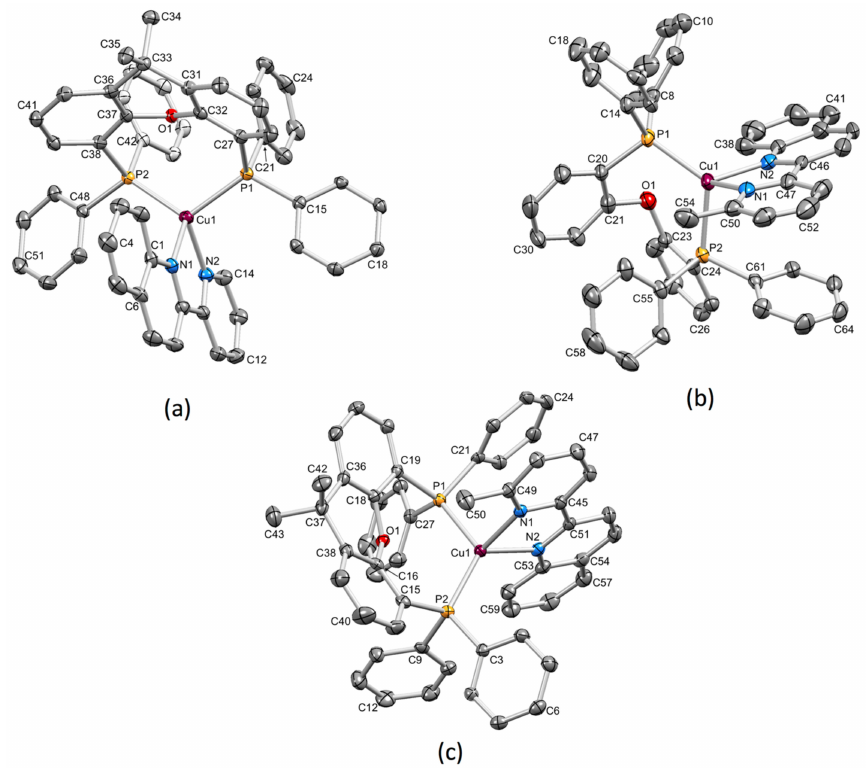
Figure 5. ORTEP representations of the structures of the complex cations in ( a ) [Cu(xantphos)( 1 )][PF 6 ], ( b ) [Cu(POP)( 2 )][PF 6 ], and ( c) [Cu(xantphos)( 2 )][PF 6 ]. Ellipsoids are plotted at 40% probability level and H atoms are omitted for